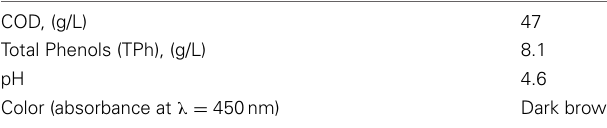
Table 1 | Properties of OMW samples used in this study.